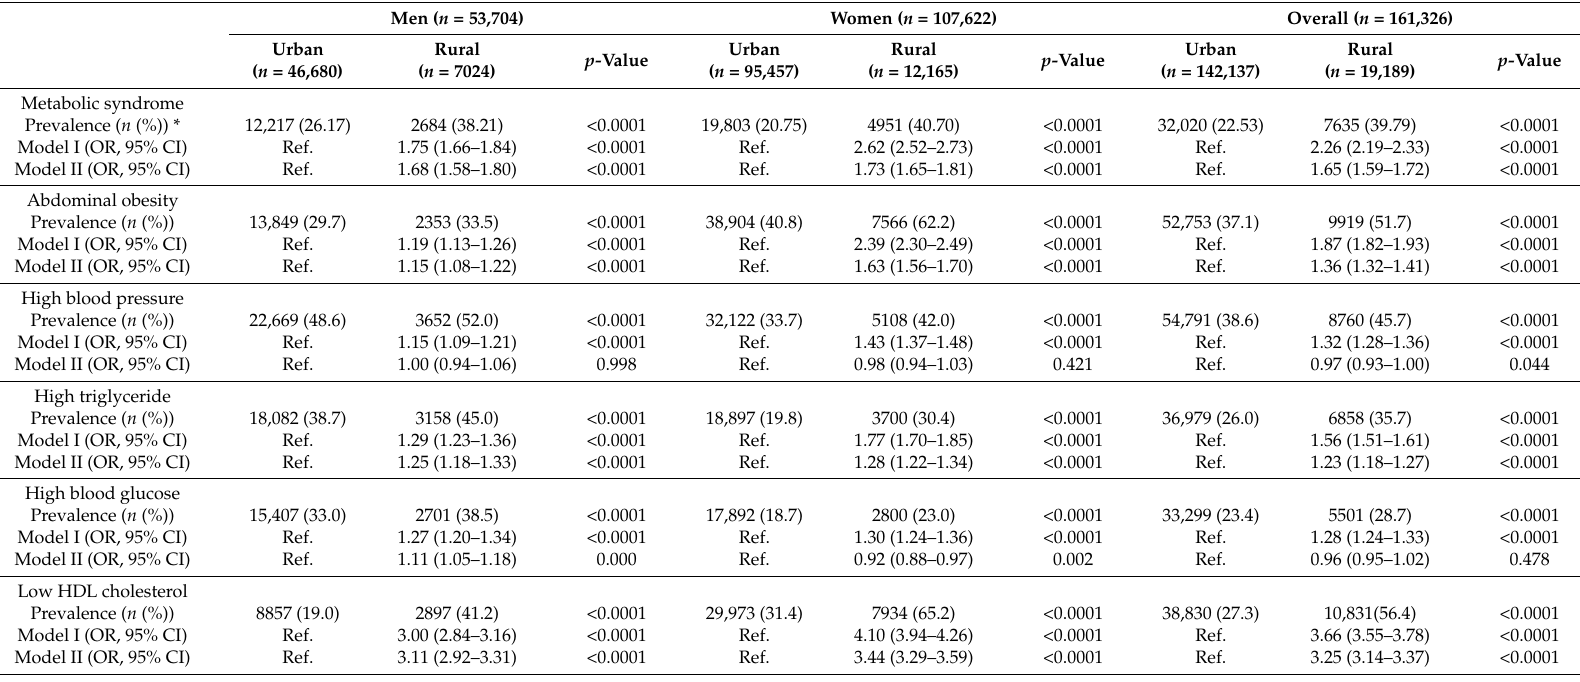
Table 4. Prevalence and odds ratio (95% CI) of metabolic syndrome and components of rural and urban Korean